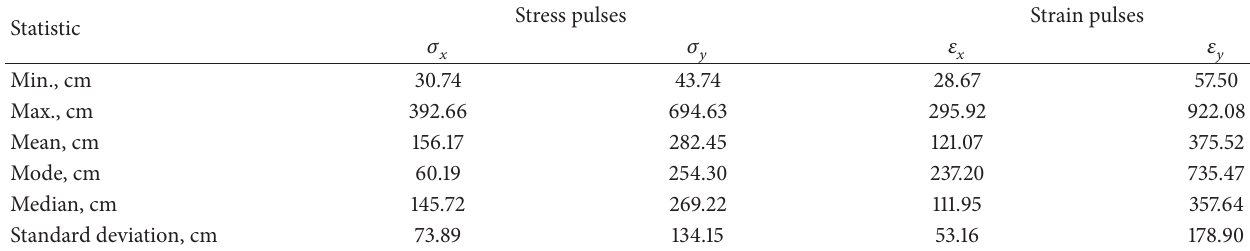
) of tensile response eff